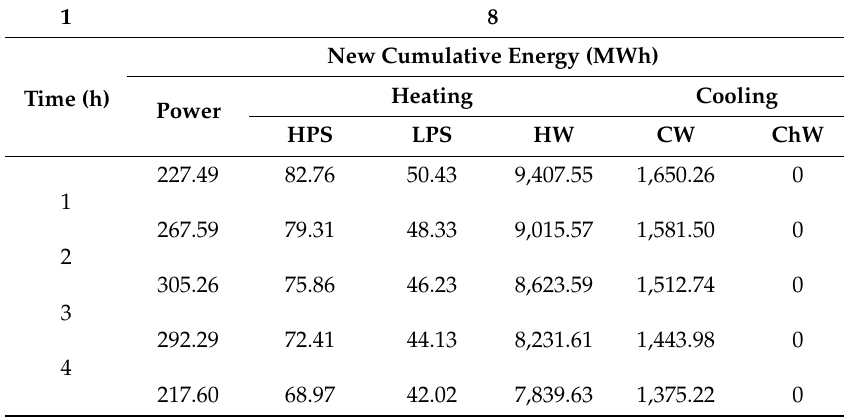
Table A7. TriGenSCA before iteration from 1 to 12